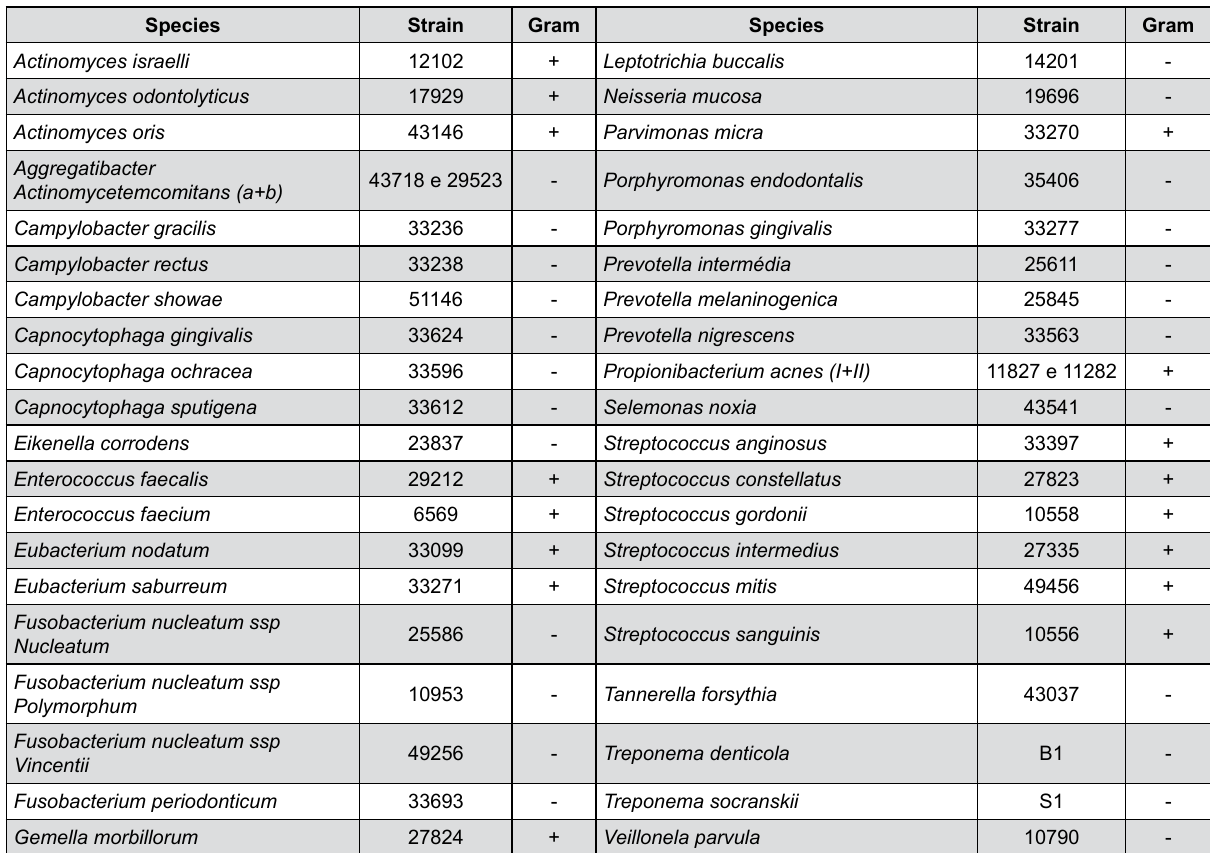
Figure 3- Bacterial strains used for the development of DNA